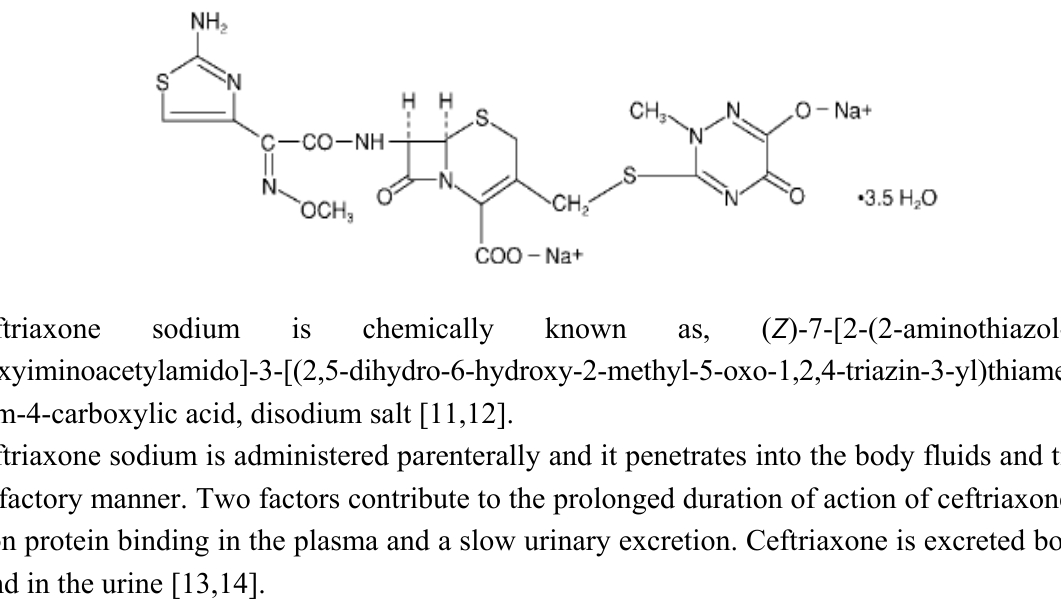
Figure 1. Chemical structure of ceftriaxone sodium (CAS